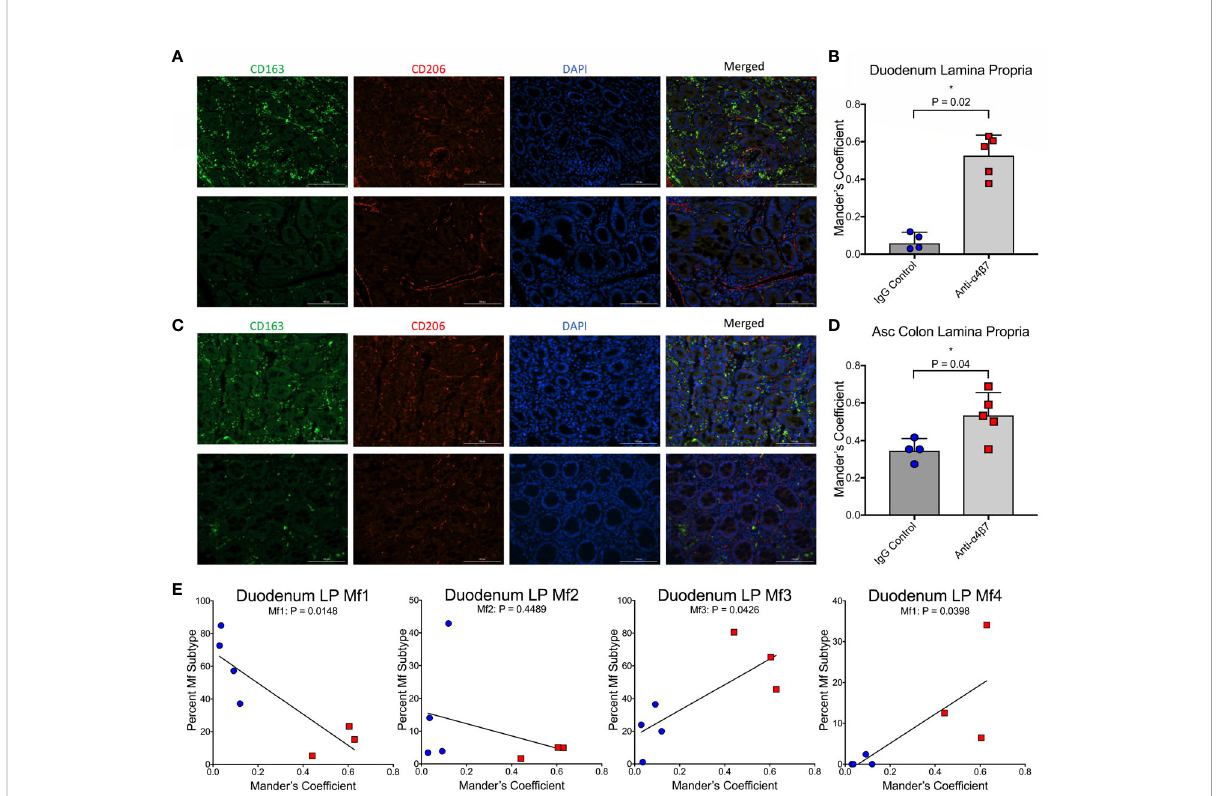
FIGURE 2 Anti- a 4 b 7 therapy is associated with increased CD206+ expression on CD163+ cells. (A) Immuno fl uorescence microscopy was used to compare the expression of CD163 and CD206 in duodenum tissue from anti- a 4 b 7 -treated (above) and IgG controls (below). (B) Co-localization was quanti fi ed with Mander ’ s coef fi cient 1, showing the ratio of co-localization of CD206 with CD163. (C) Immuno fl uorescence and (D) co- localization were also determined for anti- a 4 b 7 -treated (above) and IgG controls (below) in the ascending colon. (E) Linear regression analysis was used to compare co-localization with duodenal lamina propria macrophage subtypes determined by fl ow cytometry. * P <